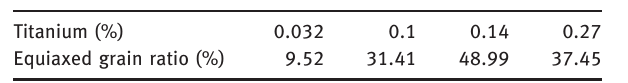
Table 2: Change of equiaxed grain ratio with the change of Ti